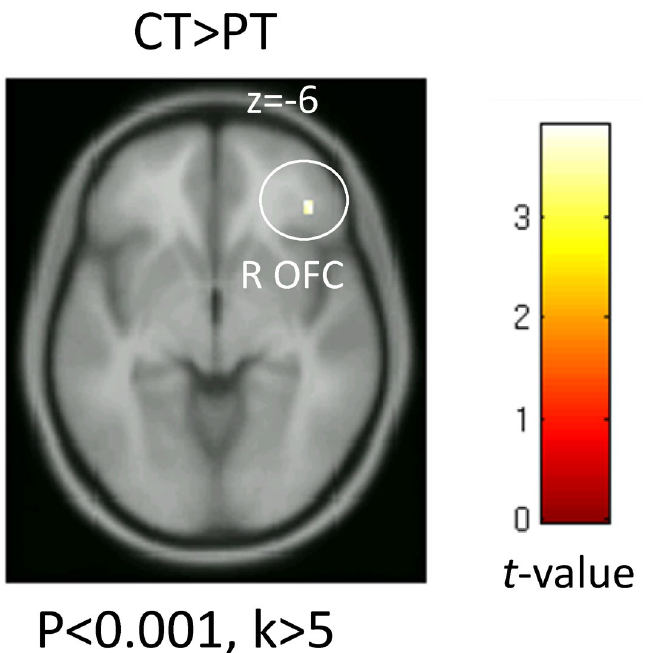
Figure 3. Brain activity in response to the conscious presentation of happiness. The map shows a significantly greater activation in response to conscious happy face stimuli in the healthy control than the insomnia patient group. Significant differences were observed in the right orbitofrontal cortex (OFC). Significant clusters are rendered on a T1 anatomical referential image displayed in neurological convention, with the left side corresponding to the left